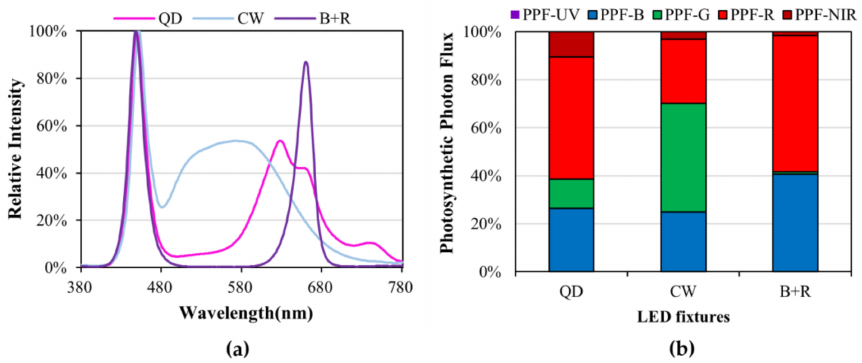
Figure 6. ( a ) Spectrum relative intensity of LED fixtures used in the experiment. QD, quantum dot; CW, cool-white; B+R, blue + red. ( b ) PPF-UV (380~399 nm), PPF-B (400~499 nm), PPF-G (500~599 nm), PPF-R (600~699 nm), and PPF-NIR (700–780 nm) 100% stacked bar graph for the LED fixtures used in the experiment.